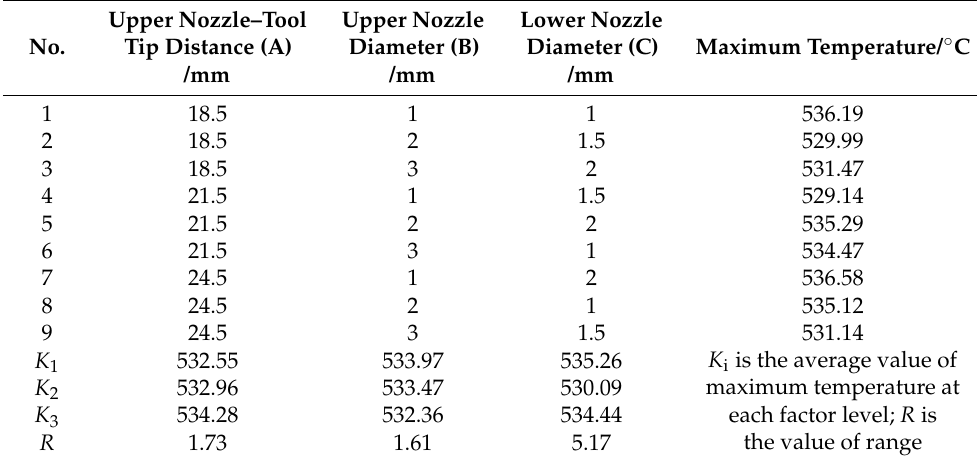
Table 3. Simulation results and range analysis of L 9 (3 4 ) orthogonal test.